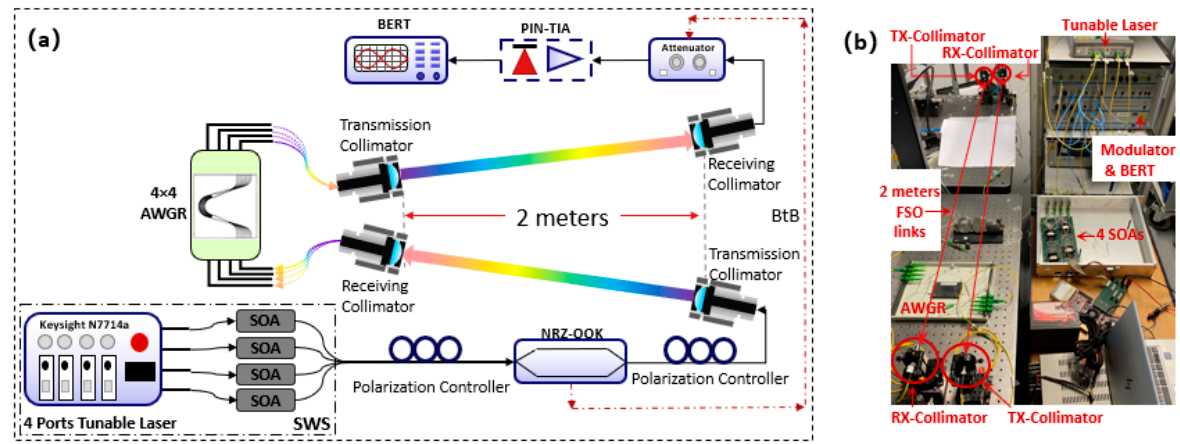
Figure 6. ( a ). Experimental setup of one cluster with 4 × 4 ‐ rack OW ‐ DCN. BERT: bit error ‐ rate tester; ( b ) the actual setup.